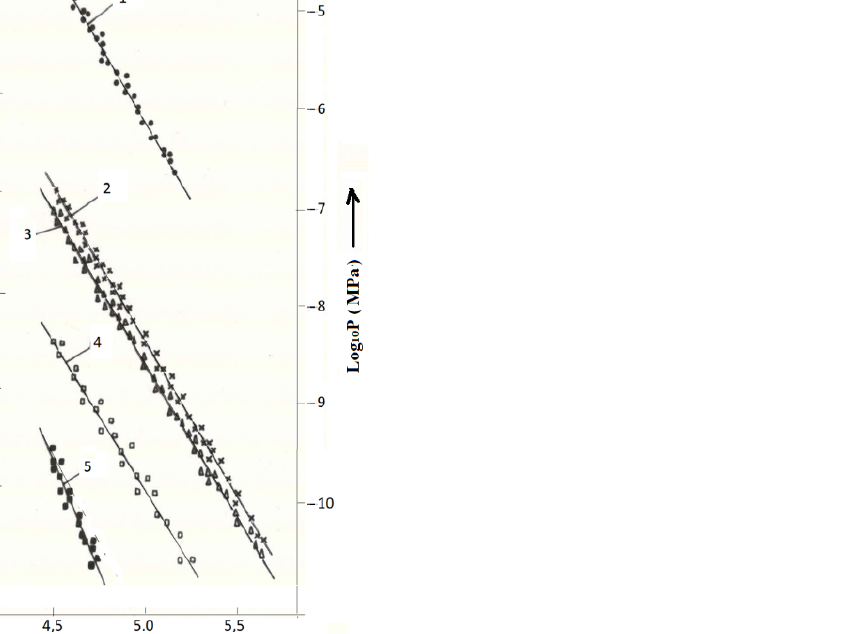
Figure 2. Dependence of partial pressures of gas phase components on temperature in Arrhenius coordinates over composition of sample 2 in Table 2 or No. 14 in Table 5: 1—nitrogen, 2—uranium, 3—uranium monoxide, 4—uranium dioxide, 5—zirconium.